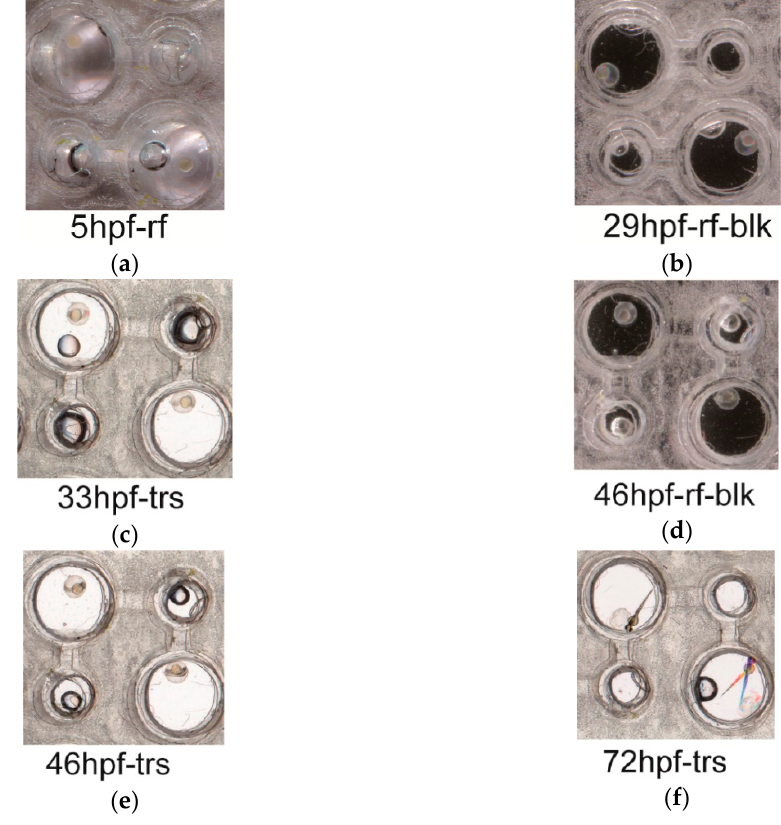
Figure 6. The developments of fish embryos in fish cells. Selected embryos of zebra fish were placed in the fish cells, and their developments at 5 hpf ( a ), 29 hpf ( b ), 33 hpf ( c ), 46 hpf ( d,e ), and 72 hpf ( f ) were photographed at 1200 dpi with a home scanner. Image scans were conducted with transmitting light ( c,e,f ) or reflective light without ( a ) or with a black ( b,d ) top cover. Dual fish images at the lower right cell ( f ) were caused by the movements of the larva fish during the scan. Methods—the fertilized eggs with signs of cell divisions were collected at ~4.5 hpf and placed in the chambers of the chip for first observation. A flow rate of 4 mL/h. was applied to the device. Since the color and transparency of the fish body varied during the embryo development, we tried three different modes of image scanning to take pictures of the fish embryos. Apparently, the scans with the reflective light without a black background did not yield clear images of the 5 hpf embryos. Also, the images by the reflect light with a black background were not as clear as those by the transmitted light. Three repeats of device-building and embryo-cultivation yielded similar